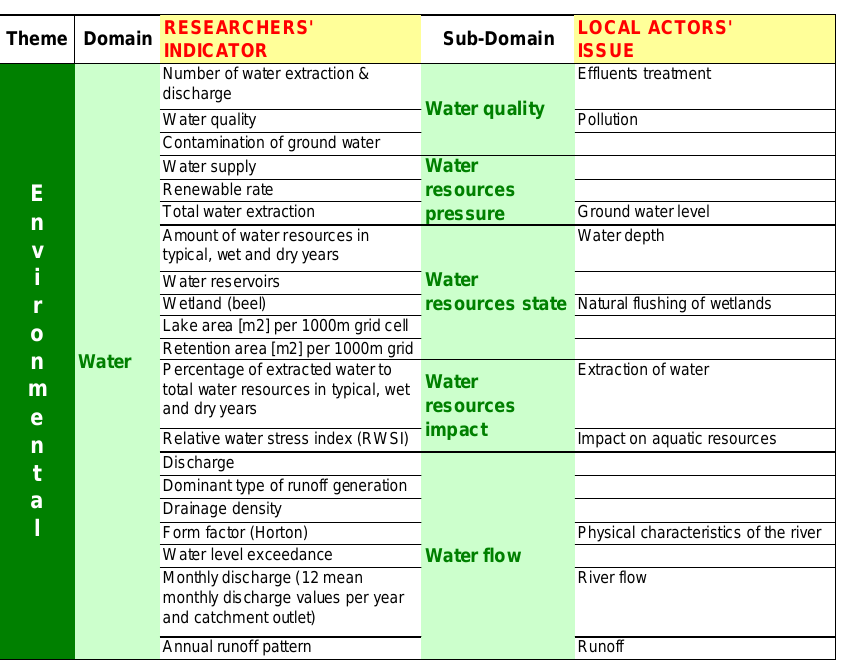
Table 2. IIT section: Example of matching local actors’ opinions with BRAHMATWINN researchers’